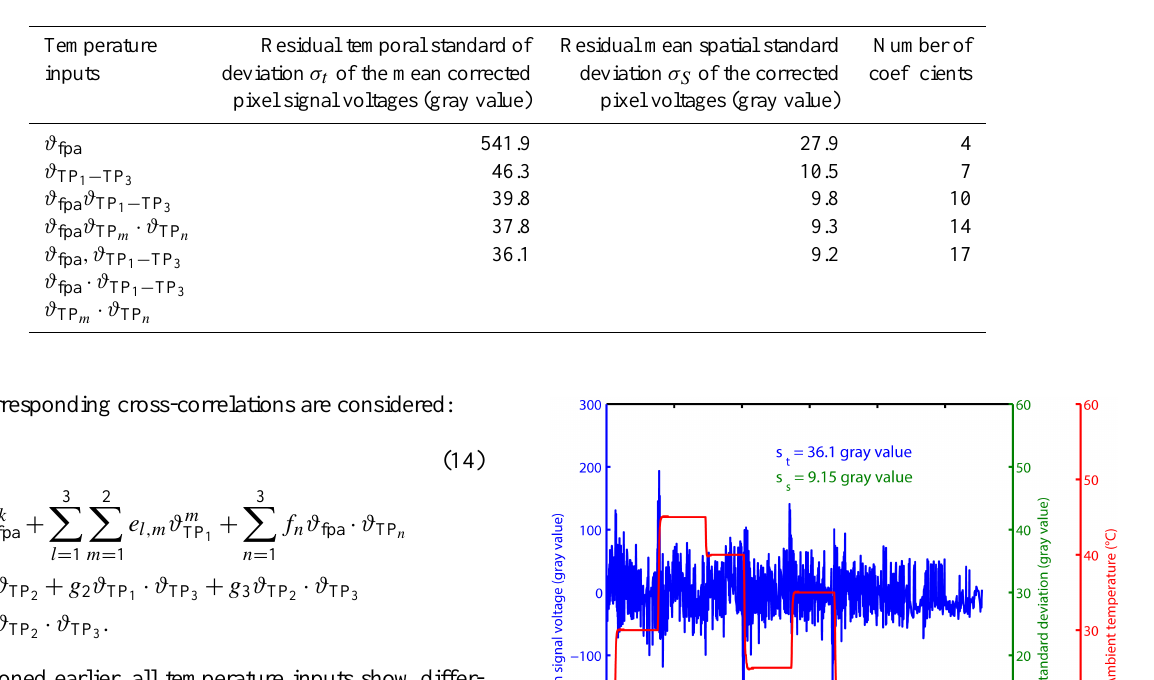
Table 3. Residual uncertainty after offset correction using different numbers and kinds of temperature inputs.